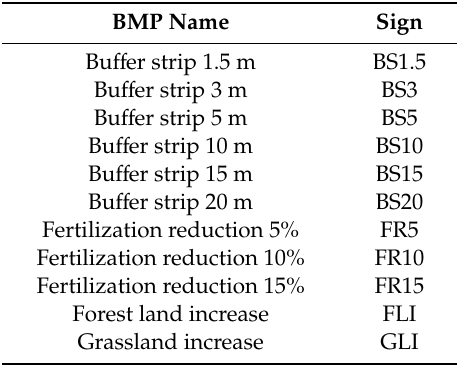
Table 1. Best management practices (BMPs) names and